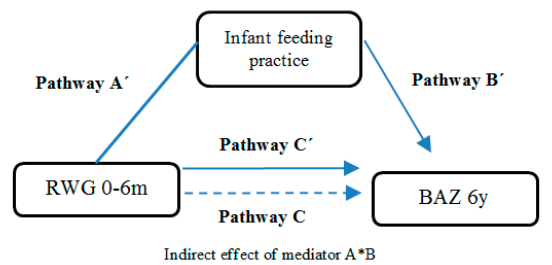
Figure 3. Graphical illustration of the significant interactions between rapid weight gain, type of feeding, and BAz at 6 years. Table 3. The mediation of infant feeding practice during the first 120 days of life between rapid weight gain during the first semester of life and BAz at 6 years.